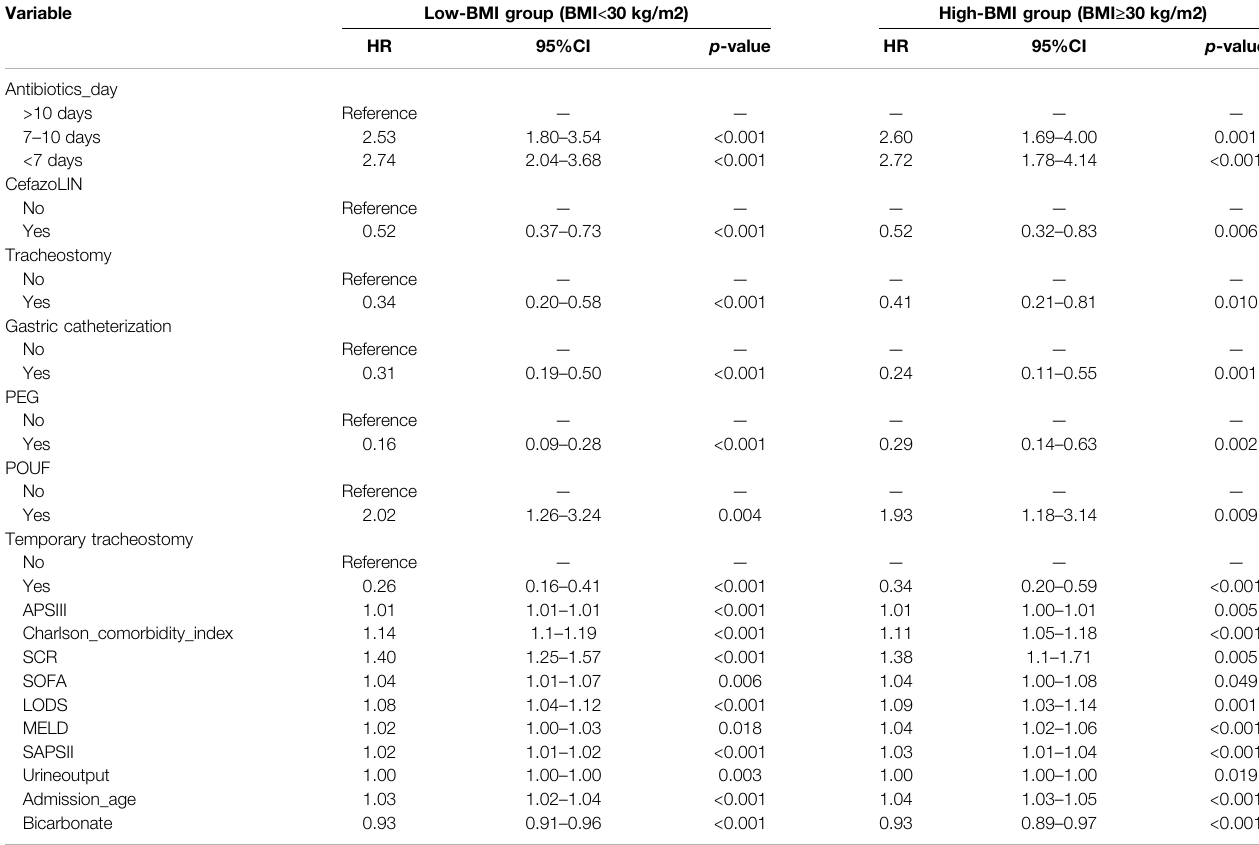
TABLE 5 | univariate cox regression results for different BMI groups. Variable